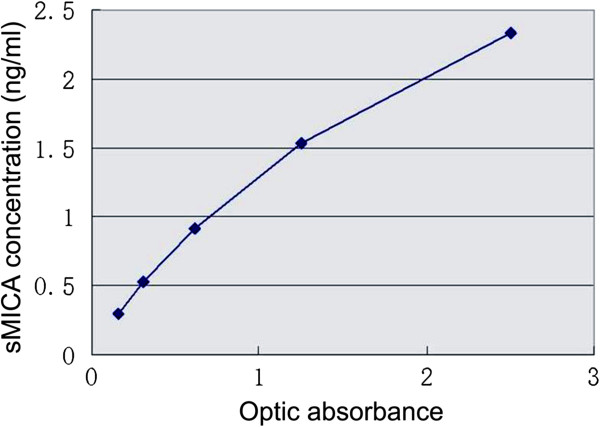
Example of the standard curve for serum soluble Major histocompatibility Complex class I related chain A (sMICA) generated by Sandwich ELISA in a typical assay. Concentrations of the recombinant MICA*008 are plotted against the readings of optic absorbance. A liner relationship exists between the values of optic absorbance and concentrations of the MICA*008. The values are averaged from duplicated loadings at each concentration.